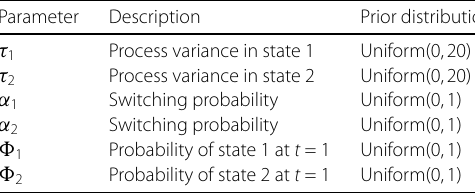
Table 4 Prior distributions for model parameters of the CGLSSM